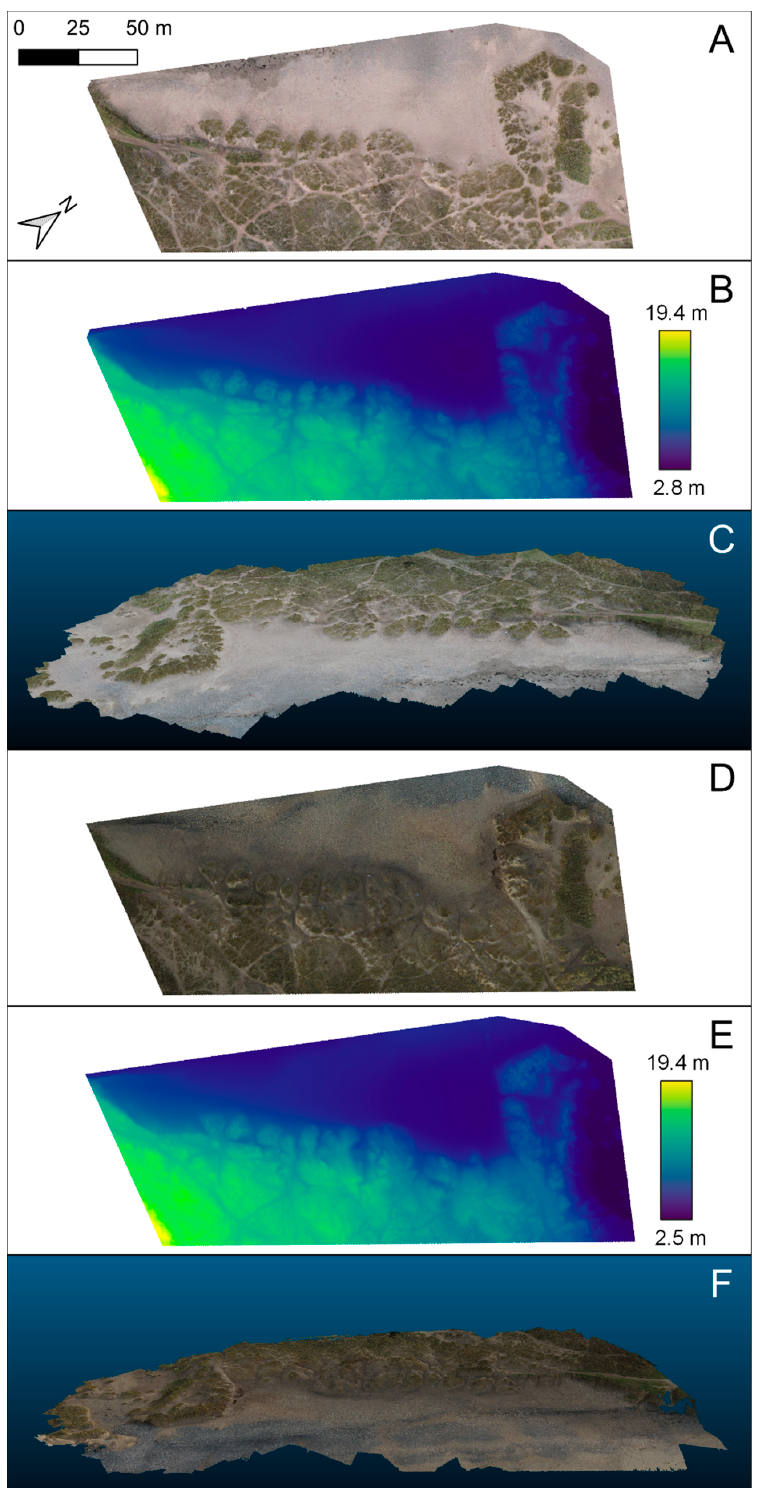
Figure 4. ( A ) Orthomosaic constructed with data from survey 4 conducted on 20 January 2017; ( B ) Digital Elevation Model (DEM) of survey 4; ( C ) Screenshot of dense point cloud made with data from survey 4; ( D ) Orthomosaic constructed with data from survey 6 conducted on 12 January 2017; ( E ) DEM of survey 6; ( F ) Screenshot of dense point cloud made with data from survey 6. Scale bar in ( A ) also applied to ( B , D , E ).